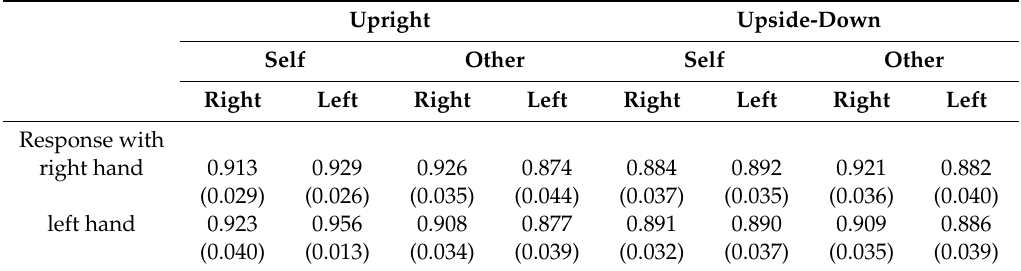
Table 1. Mean accuracy (standard errors) of discrimination between self and other’s hand when responding with the right and left hands (Task 1).